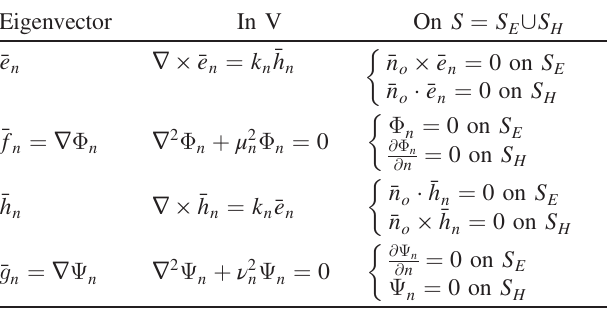
TABLE I. Eigenvector equations. Eigenvector In